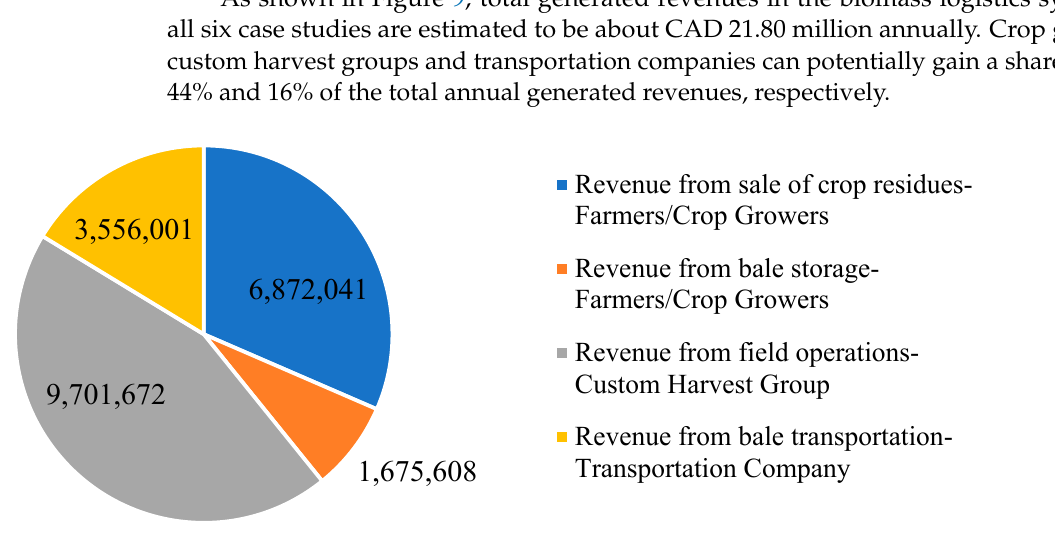
Figure 8. Annual revenue generated in the upstream biomass logistics system by supplying agricultural biomass for the pellet plant.